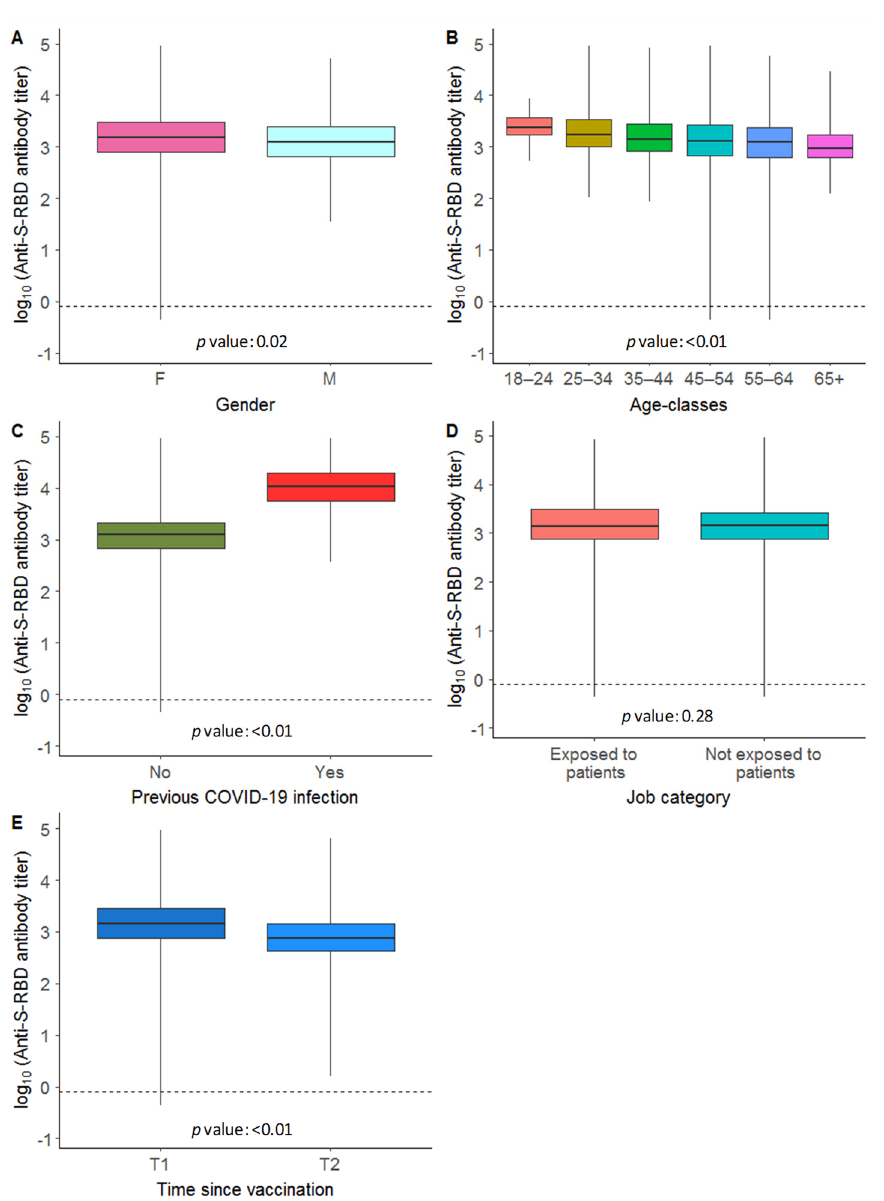
Figure 3. Distribution of the anti-S-RBD antibody titer (on log 10 scale). Boxplot of the antibody titer at T1 of the 1565 HCWs according to the baseline HCWs characteristics ( A ) gender, ( B ) age-classes, ( C ) previous infection by SAS-CoV-2 and ( D ) job category; ( E ) boxplot of the antibody titer of the 1438 HCWs at T1 and T2. Each box indicates the 25th and 75th percentiles. The horizontal line inside the box indicates the median value. Whiskers indicate the extreme measured values. The dashed line indicates the assay positivity cut-off